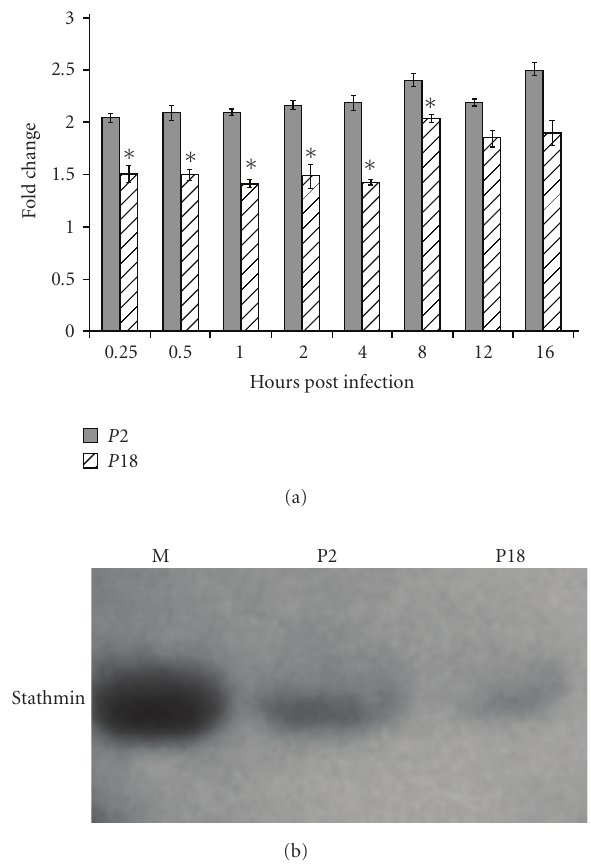
Figure 5: (a) Induction of (pro)thymosin- α expression by PICV infection. P388D1 cells were infected with either P2 or P18 PICV in triplicate and tissue culture supernatants collected at various times post infection for determination of (pro)thymosin- α levels by ELISA. Fold increases are compared to levels from triplicate samples at time = 0 and show the results from three experiments. Error bars show the standard error of the mean, and asterisks indicate significant ( P < . 05) di ff erences in levels induced between P2 and P18 infection as determined by Student’s t -test. (b) Changes in stathmin expression following infection by P2 and P18 PICV. Triplicate cultures of P388D1 cells were infected with PICV and whole cell lysates assayed or stathmin levels by